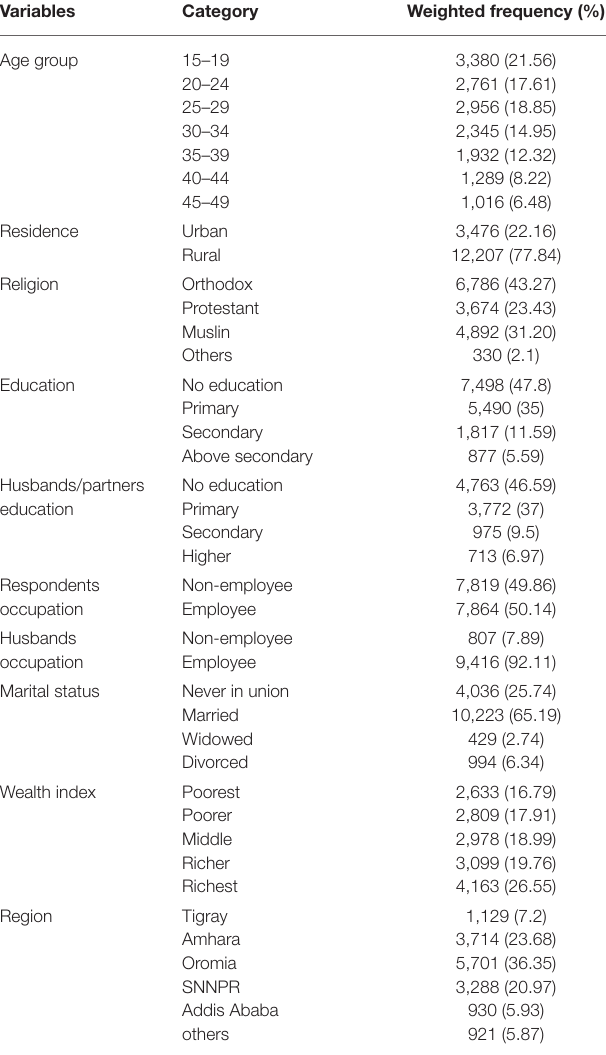
TABLE 1 | Socio demographic characteristic of the study participants in Ethiopia, 2016 ( N = 15,683).